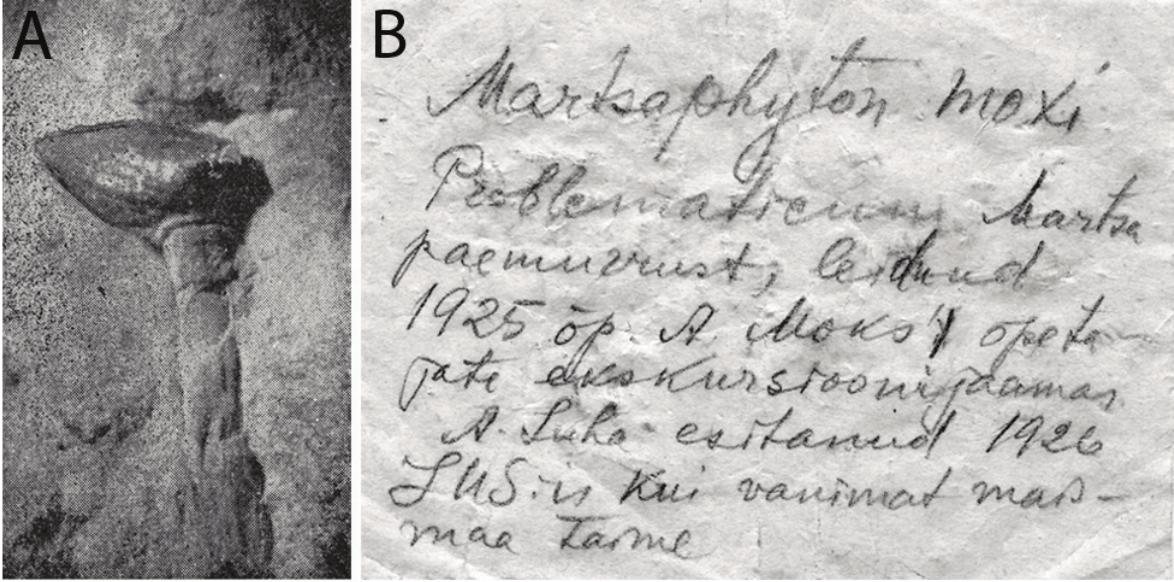
Fig. 2. A , original photo of Martsaphyton moxi gen. et sp. nov., published in 1967; B , the label accompanied by the specimen. The text on the label says: Martsaphyton moxi . Problematic from the Martsa quarry, found in 1925 by teach. A. Moks in the teachers’ excursion station. Presented by A. Luha as the oldest land plant at the Estonian Naturalists’ Society in